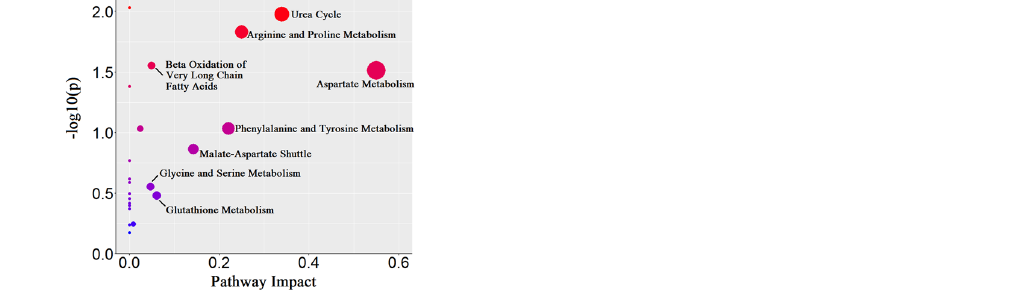
Figure 5. A pathway impact analysis based on differential metabolites between GC and HC groups in training set. Eight perturbed metabolic pathways were indicated for patients with